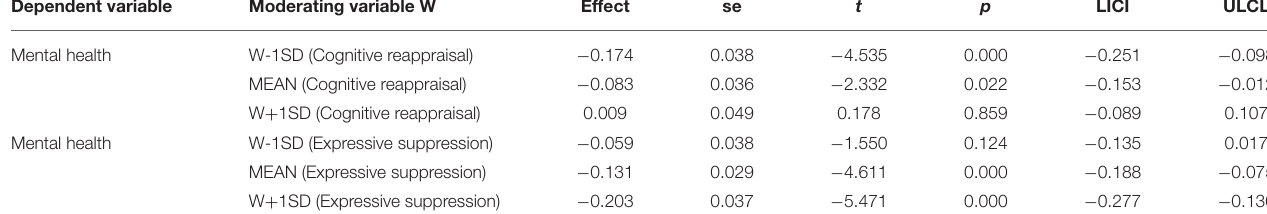
TABLE 3 | The effect size of the moderating effect of emotion regulation style on the different pathways of meaning in life and mental health of frontline nurses. Dependent variable